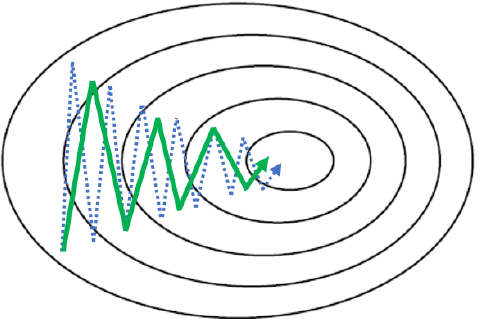
Figure A3. Schematic gradient contour map comparing SGD without (blue dotted line) and with (green solid line) momentum. Note the reduction in oscillations in the second case, which helps avoid local minima by taking a more direct path to the valley bottom, thus improving and accelerating convergence.